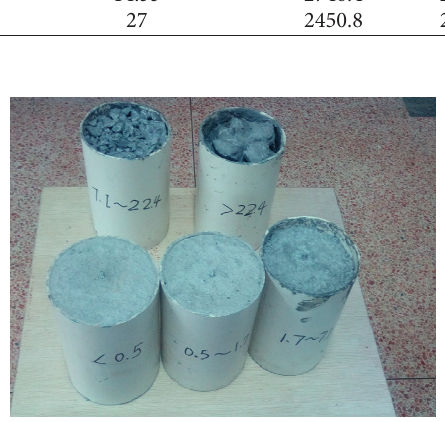
Figure 1: Appearance of concrete specimens used for rock drilling experiments.